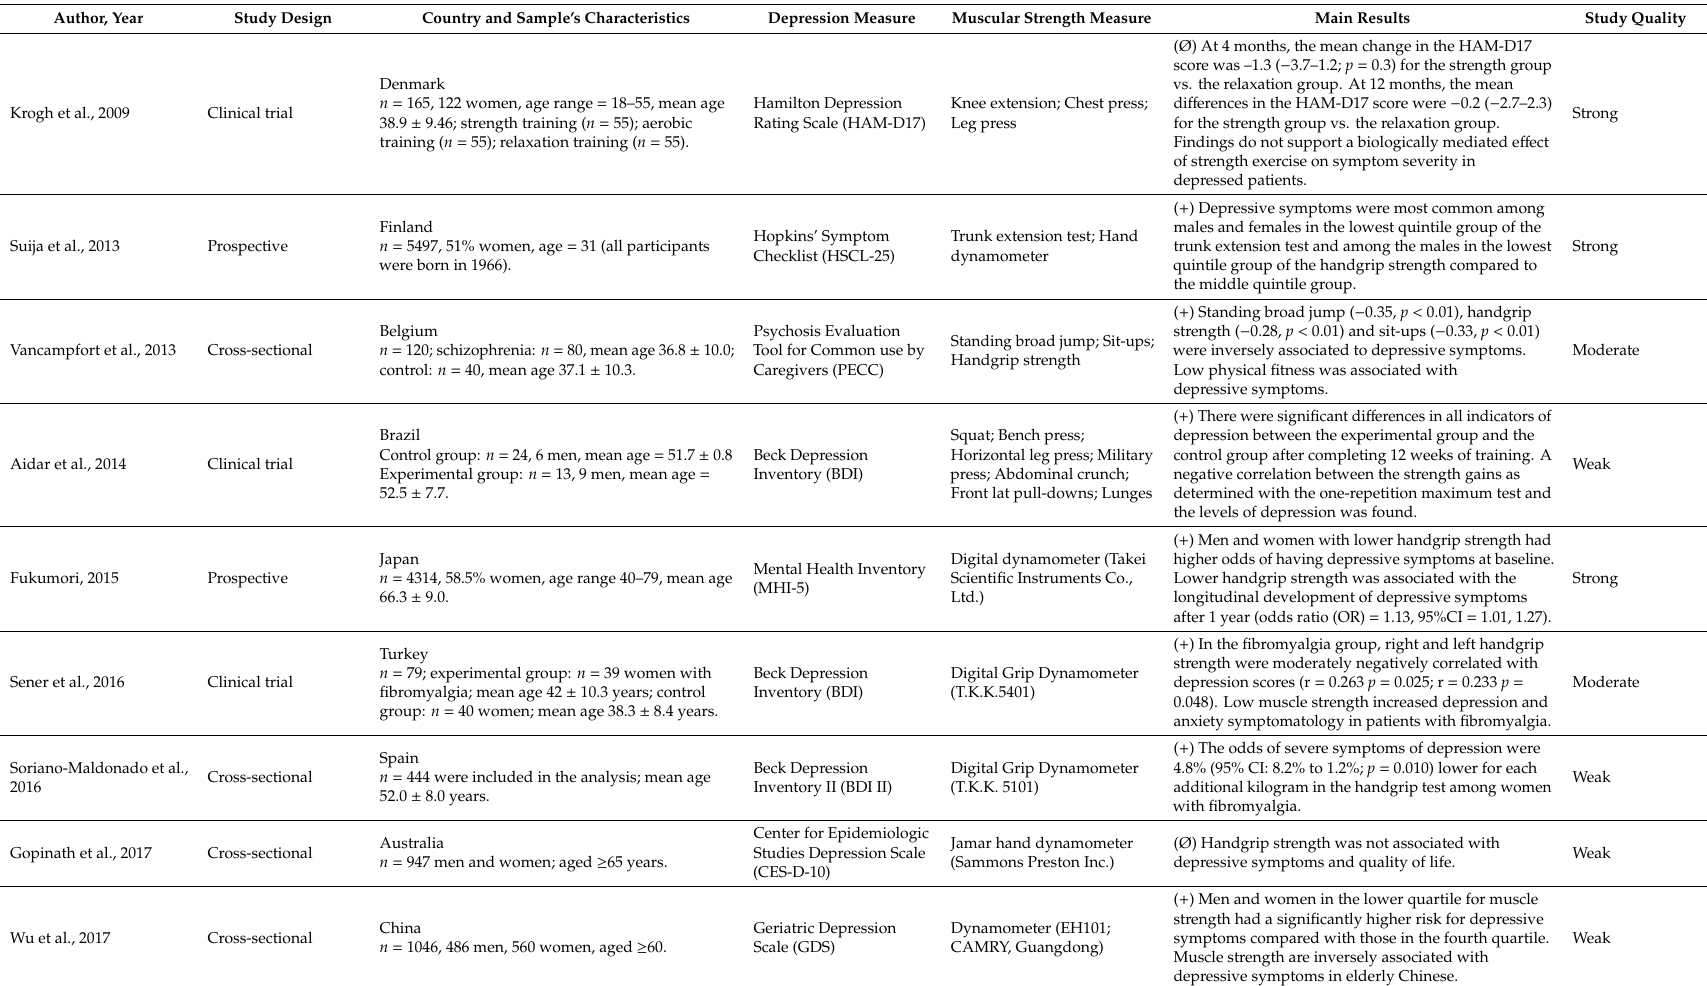
Table 1. Studies’ characteristics.